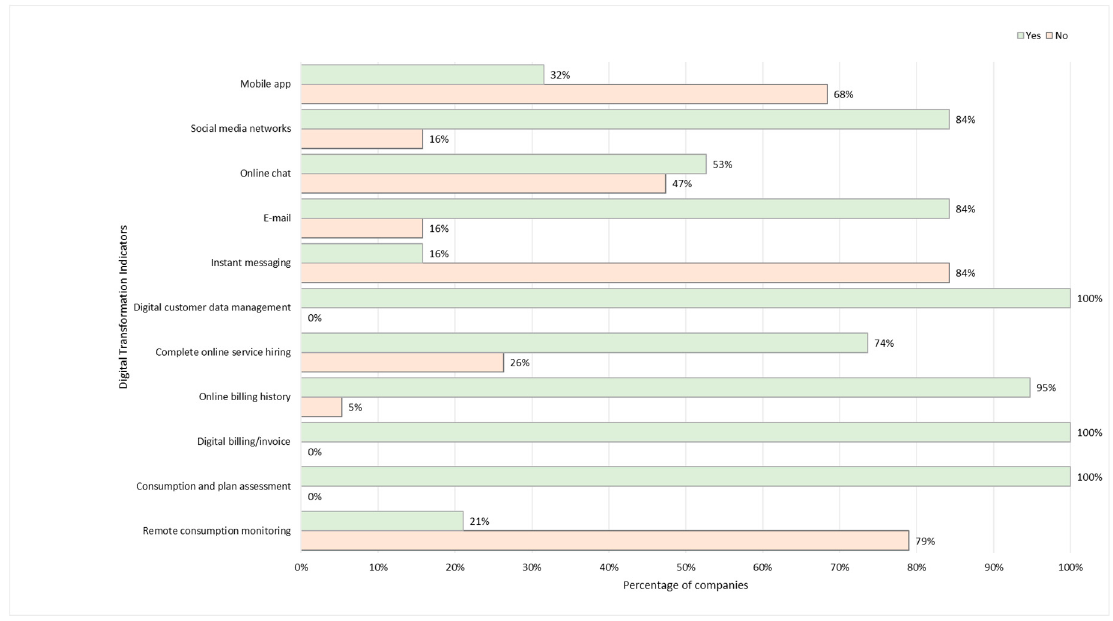
Figure 3. Indicators of digital transformation across free-market Spanish national electricity retailers.